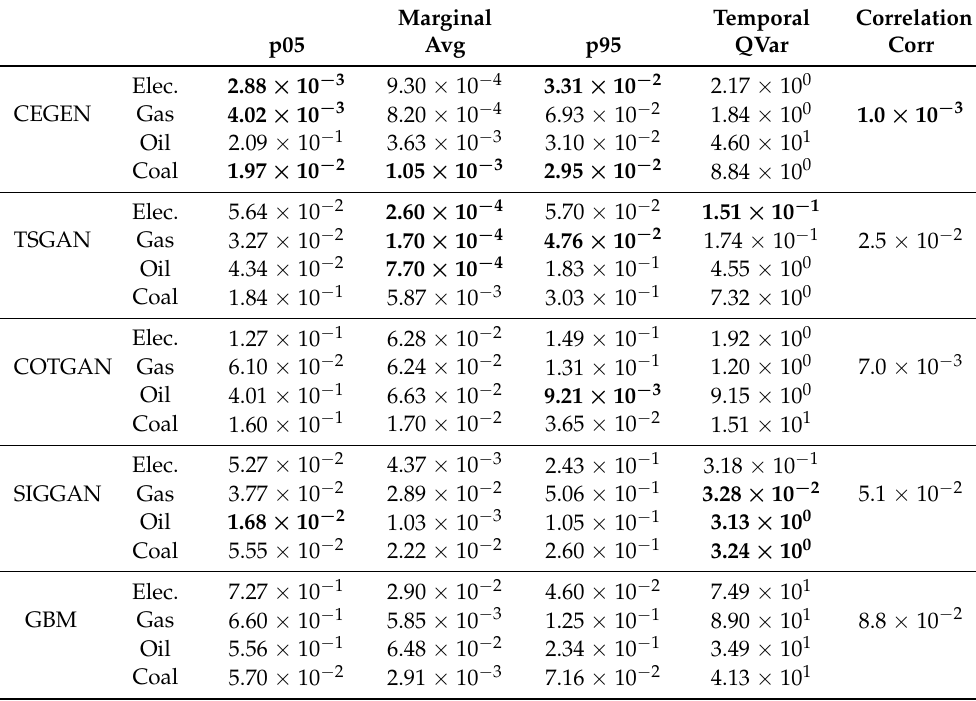
Table 1. Evaluation metrics on joint simulation of electricity, natural gas, coal and oil 3-month futures contracts prices. For all metrics, the lower, the better. Bold values indicate best